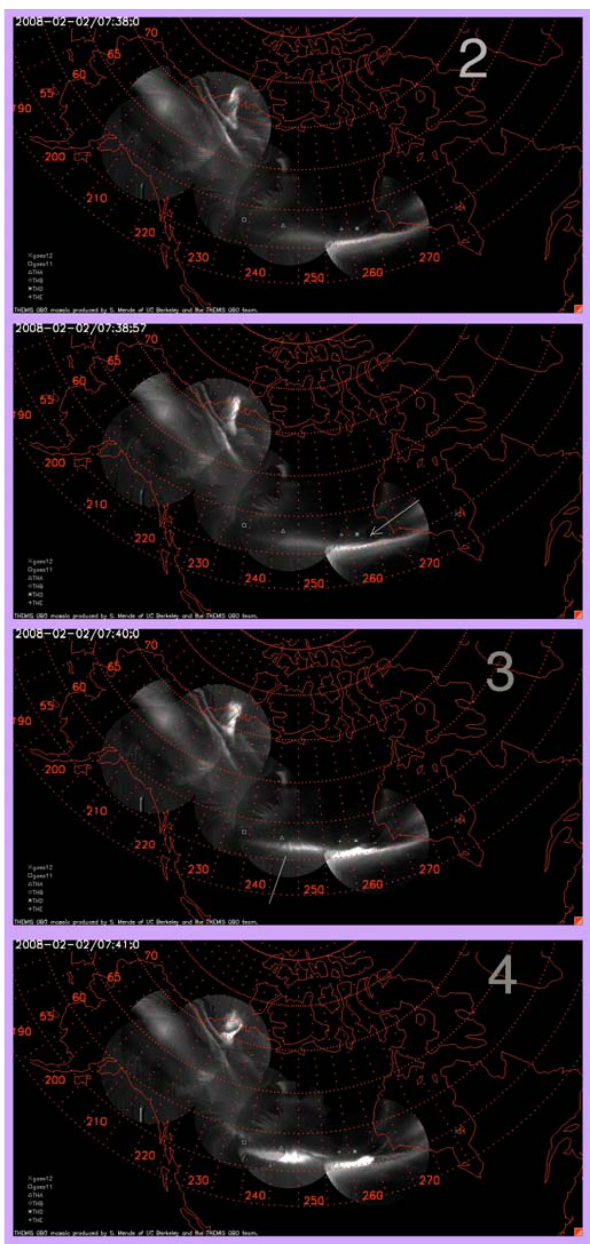
Fig. 7. Collage of image mosaics. Stations displayed from right to left are, Gillam, Ft. Smith, Ft. Simpson then Gakona (South), Ft. Yukon (middle) and Inuvik (North). The numerals on the top right are the identifiers of the various events as described in the caption of Fig. 4.